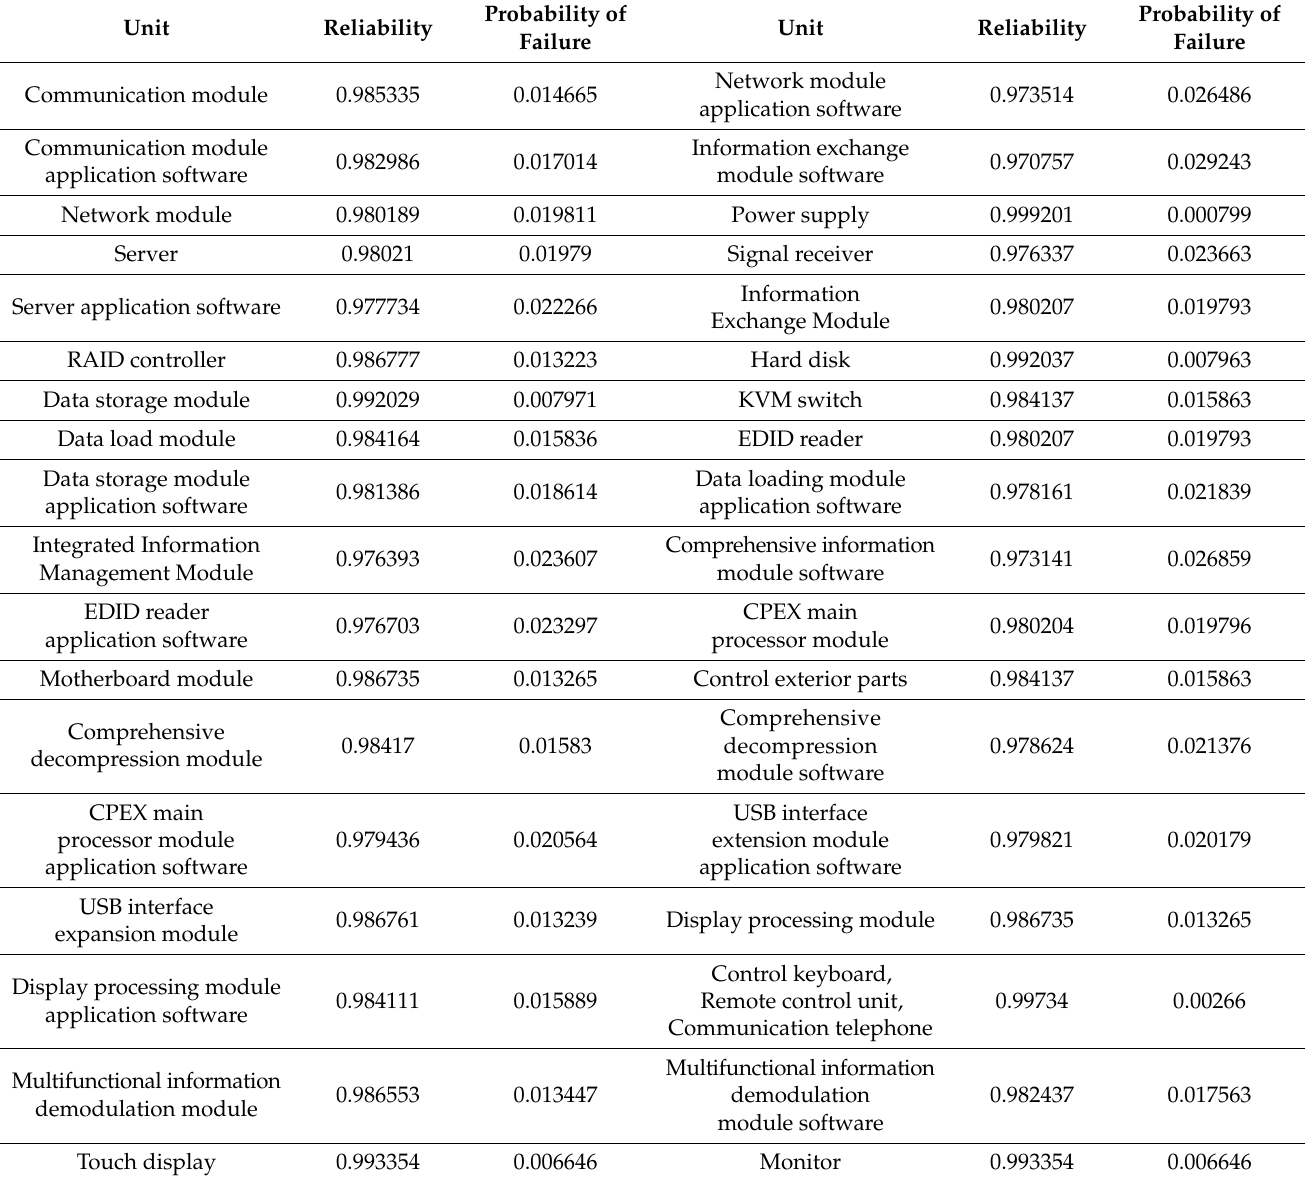
Table 4. C 4 ISR System unit Reliability (100 h working